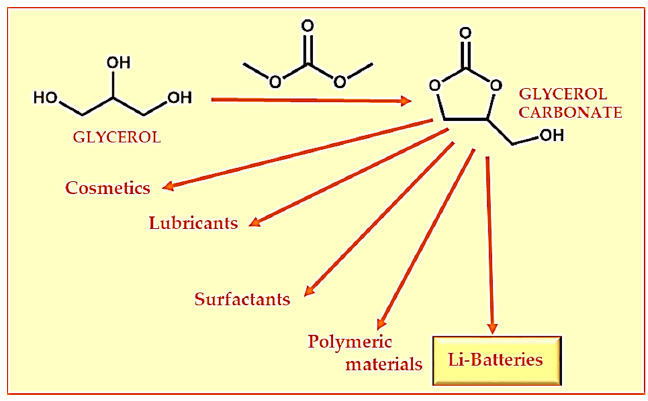
Figure 2. Industrial production of glycerol carbonates and some applications.